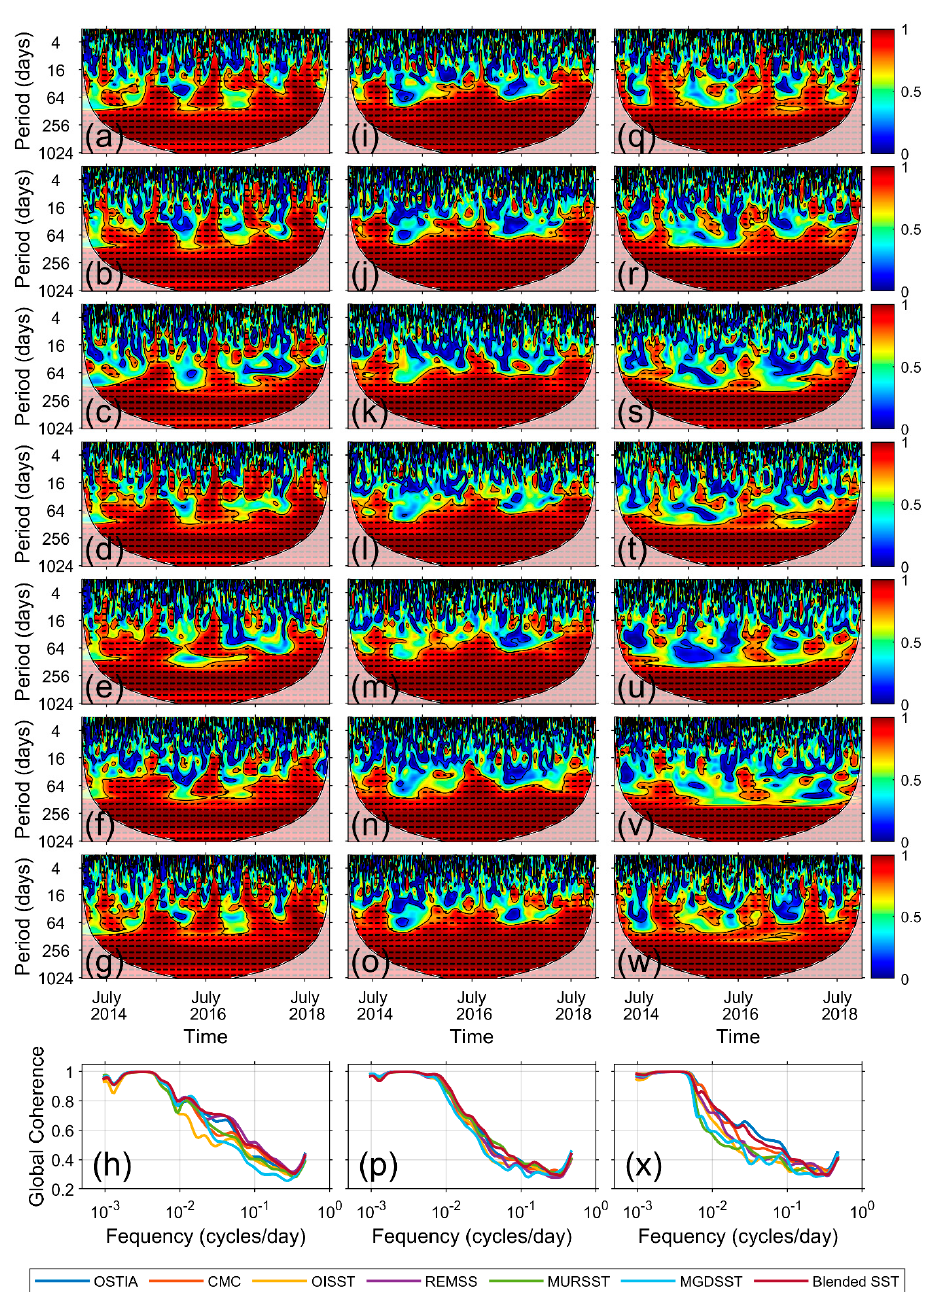
Figure 8. Wavelet coherence between in-situ temperature and ( a ) OSTIA, ( b ) CMC analysis, ( c ) OISST, ( d ) REMSS analysis, ( e ) MURSST, ( f ) MGDSST, and ( g ) Blended SST. ( h ) Global coherence at the location of the E4 buoy; ( i – p ) and ( q – x ) are the same as ( a – h ), but at the locations of S2 and Y10, respectively.